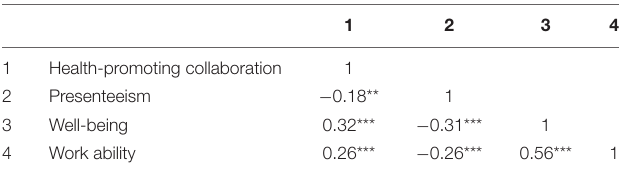
TABLE 2 | Intercorrelations of the